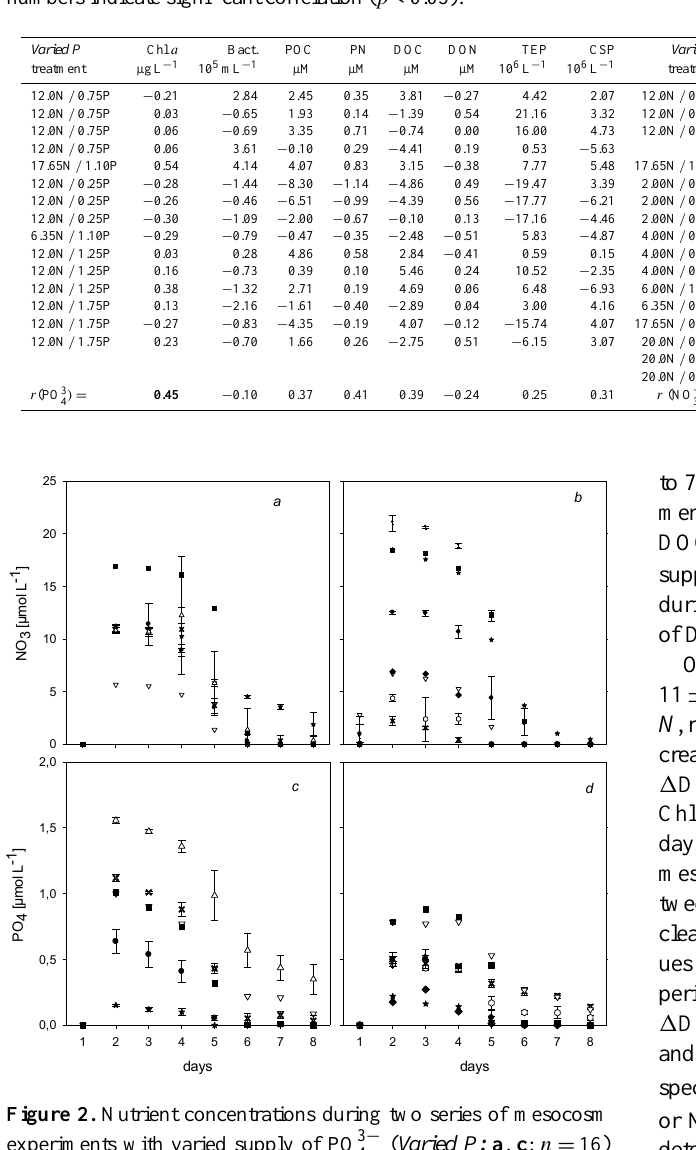
( Varied P ; µmolL − 1 ) and NO − ( Varied N ; µmolL − 1 ) concentrations; bold 4 3